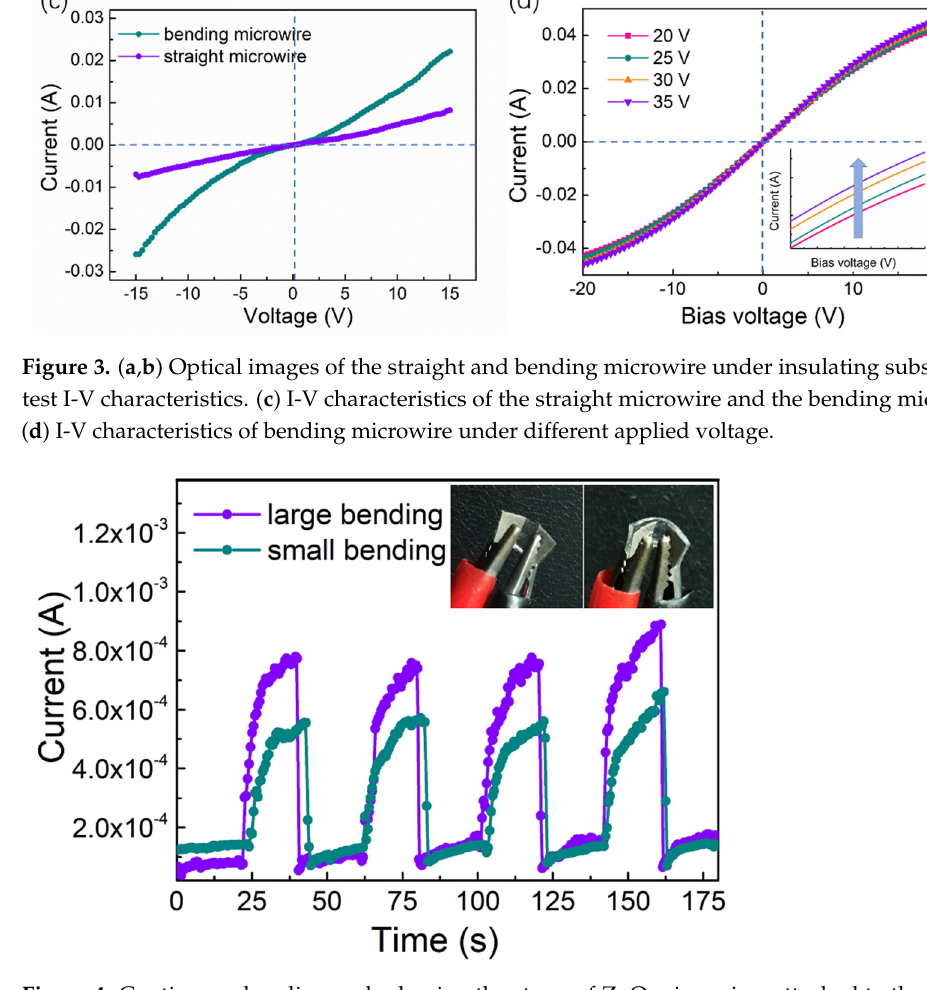
Figure 4. Continuous bending and releasing the stress of ZnO microwires attached to the flexible PDMS substrate. Inset: the images of flexible devices with different bending curvature.